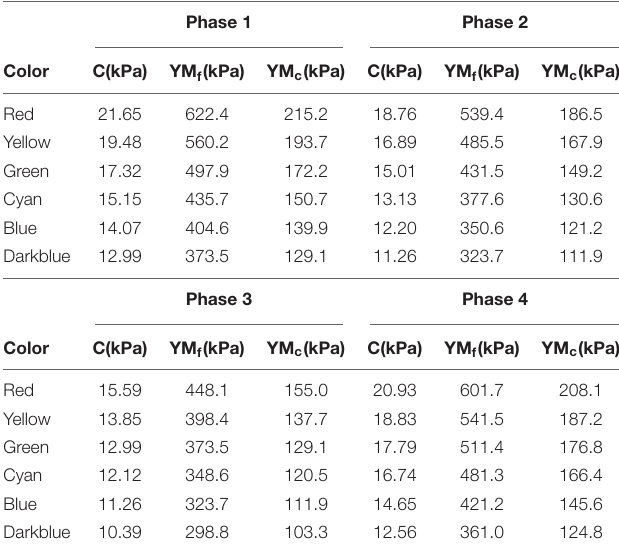
TABLE 2 | Material parameters from Right ventricular apex (RVA) model at different phases.